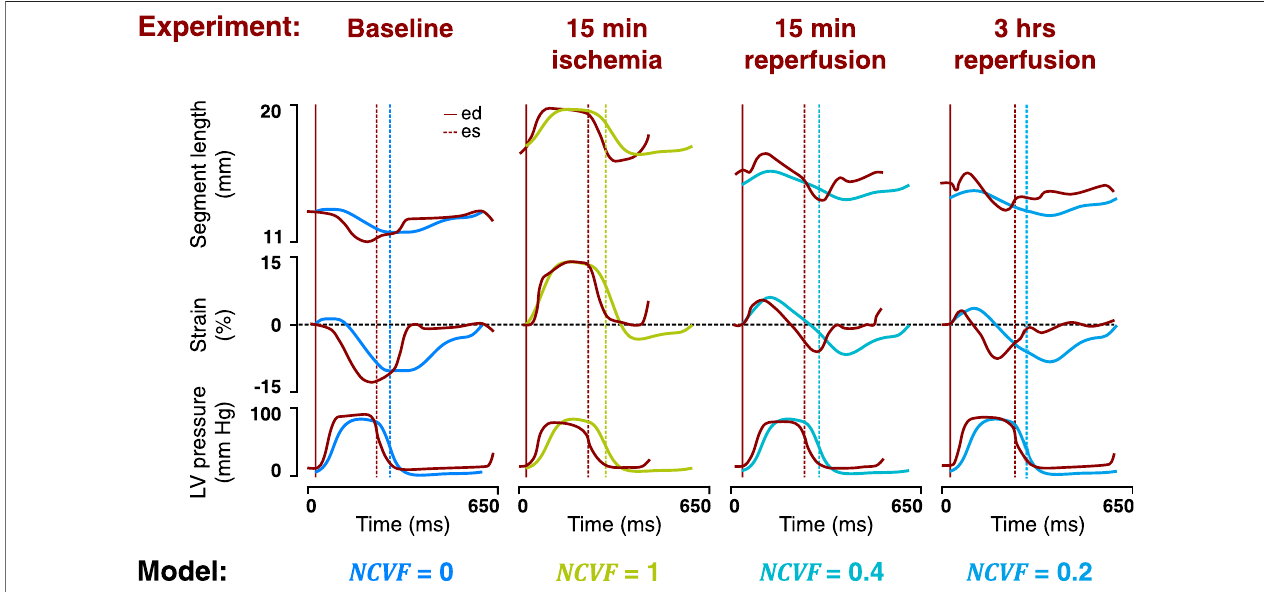
FIGURE 5 | Comparison between the temporal behavior of the measured segment length, strain, and LV pressure in the same representative dog as in Figure 4 after 15 min of left anterior descending (LAD) coronary artery occlusion followed by 15 min and 3 h of reperfusion (dark red tracings, resketched from Lyseggen et al. (2005)) and the simulated segment length, strain, and LV pressure (blue and green tracings) for the best matching severities of regional contractile dysfunction ( NCVF ). ed, end-diastole; es, end-systole.